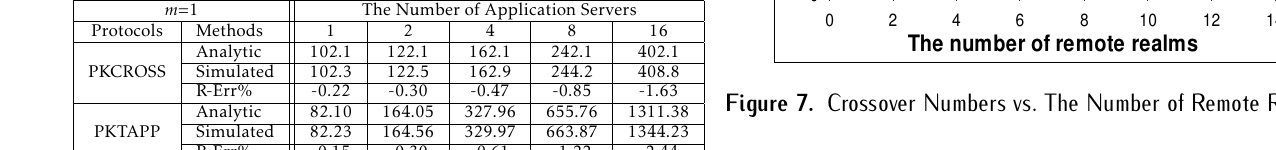
Table 3. The Comparison of Analytic and Simulated Response Times m =1